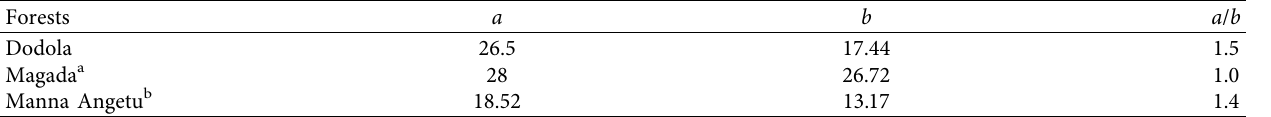
NS: not significant at 5% confidence level. Table 2: Tree density comparison of Dodola, Magada, and Manna Angetu forests.